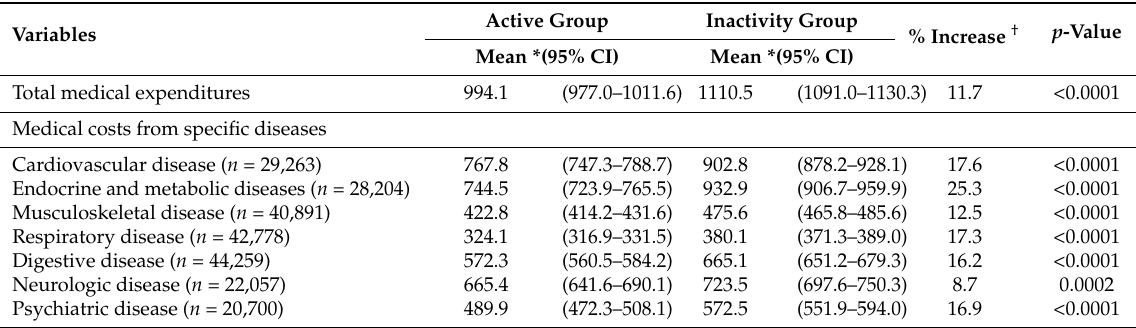
Table 2. Estimates of per capita accumulated medical costs: physically active groups and physically inactive groups (2005–2010) unit: international